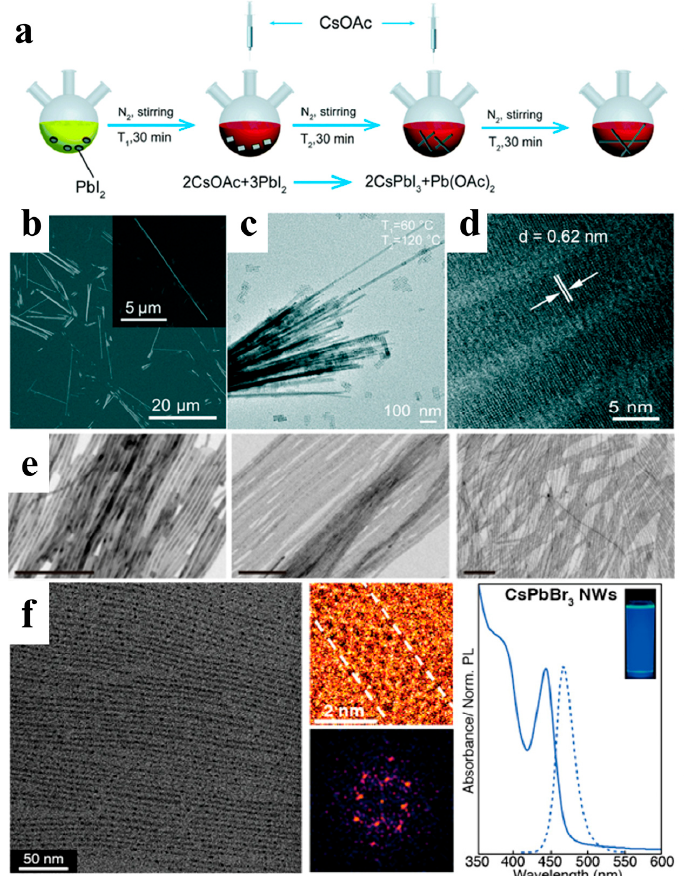
Figure 3. ( a ) Schematic diagram of the synthesis procedure with two injections at two corresponding temperatures: T1 = 60 °C and T2 = 120 °C. ( b ) Scanning electron microscope (SEM) image of the CsPbI 3 NWs. The inset shows a high‑magnification SEM image on a single CsPbI 3 NW. ( c ) Trans ‐ mission electron microscopy (TEM) image, and ( d ) high ‐ resolution TEM image of the CsPbI 3 NWs. Reprinted with permission from reference [40]. Copyright 2019, Royal Society of Chemistry. ( e ) TEM images of 10 nm, 5.1 nm, and 3.4 nm width NWs, respectively. Reprinted with permission from reference [41]. Copyright 2016, American Chemical Society. ( f ) Purified ultrathin CsPbBr 3 NWs (scale bar: 50 nm); Diffraction pattern of a single CsPbBr 3 NW; Absorption and PL spectra of CsPbBr 3 NWs. Reprinted with permission from reference [42]. Copyright 2016, American Chemical Society.